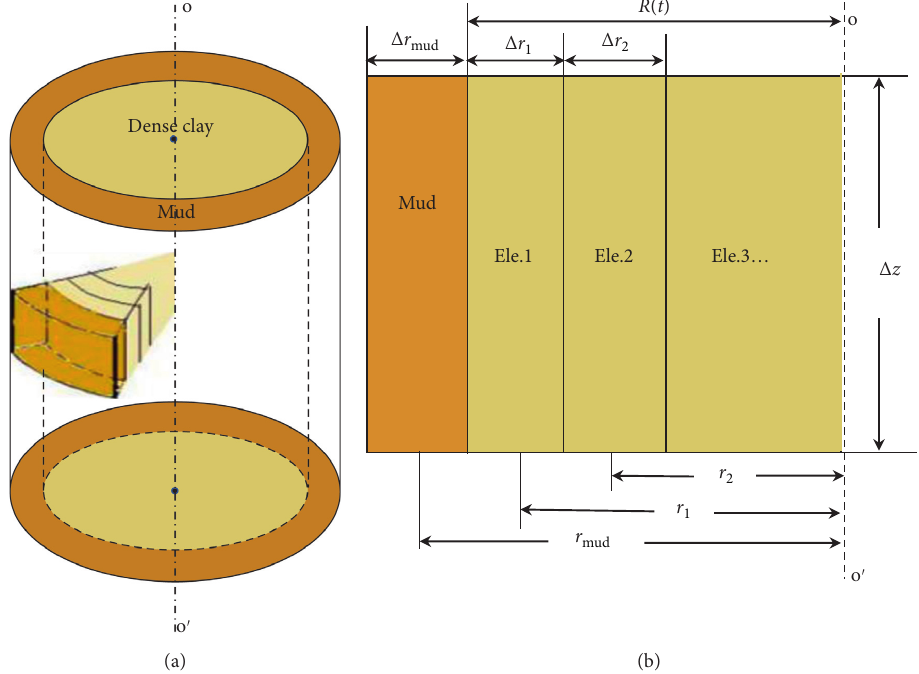
Figure 3: Schematic view of specimen and maturation. (a) Clay specimen surrounded by water-rich mud, absorbing water in radial direction. (b) Division of dense clay into elements for the numerical